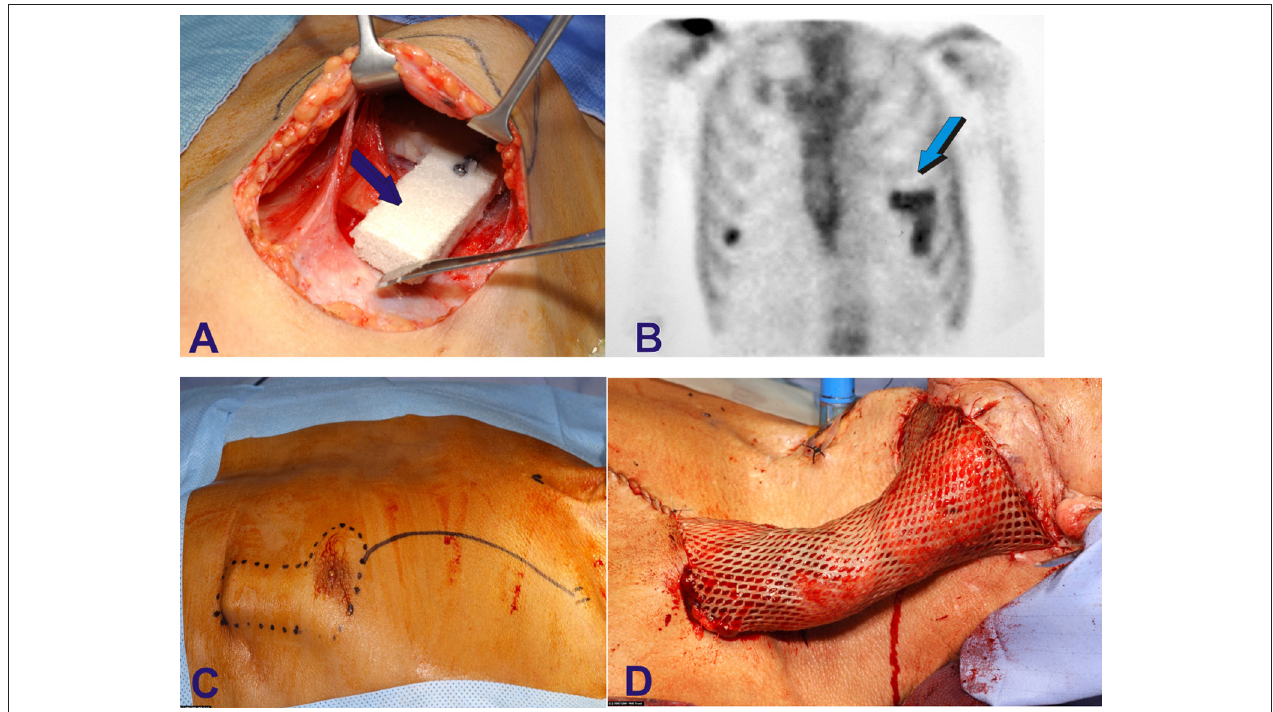
FIGURE 3 | Human intramuscular heterotopic fabrication of a hydroxyapatite/bone morphogenetic protein-7 (hBMP-7) bioreactor for auto-transplantation to large mandibular defect after squamous cell carcinoma avulsion and debridement. The compelling problem of limited osteoinduction in spite of supra-physiological doses of human recombinant morphogenetic protein-2 and -7 (hBMP-2, hBMP-7) forced the use of heterotopic vascularized muscular sites to construct pre-fabricated osteogenic implants for later auto-transplantation in orthotropic mandibular site in a human patient (Heliotis et al., 2006). (A) After the analyses of several coral-derived macroporous constructs implanted in the rectus abdominis muscle of Papio ursinus ( Ripamonti, 1991, 1996, 2006; Ripamonti et al., 1993, 2009, 2010) a L-shaped coral-derived construct was also implanted into the pectoralis maior of a human patient combined with 2.5mg doses of hBMP-7 (Heliotis et al., 2006). (B) Scintigraphy shows bone formation within the prefabricated intramuscular construct later (C) rotated with a composite myo-cutaneous flap (D) into the recipient autologous mandibular bone defect ( Heliotis et al.,